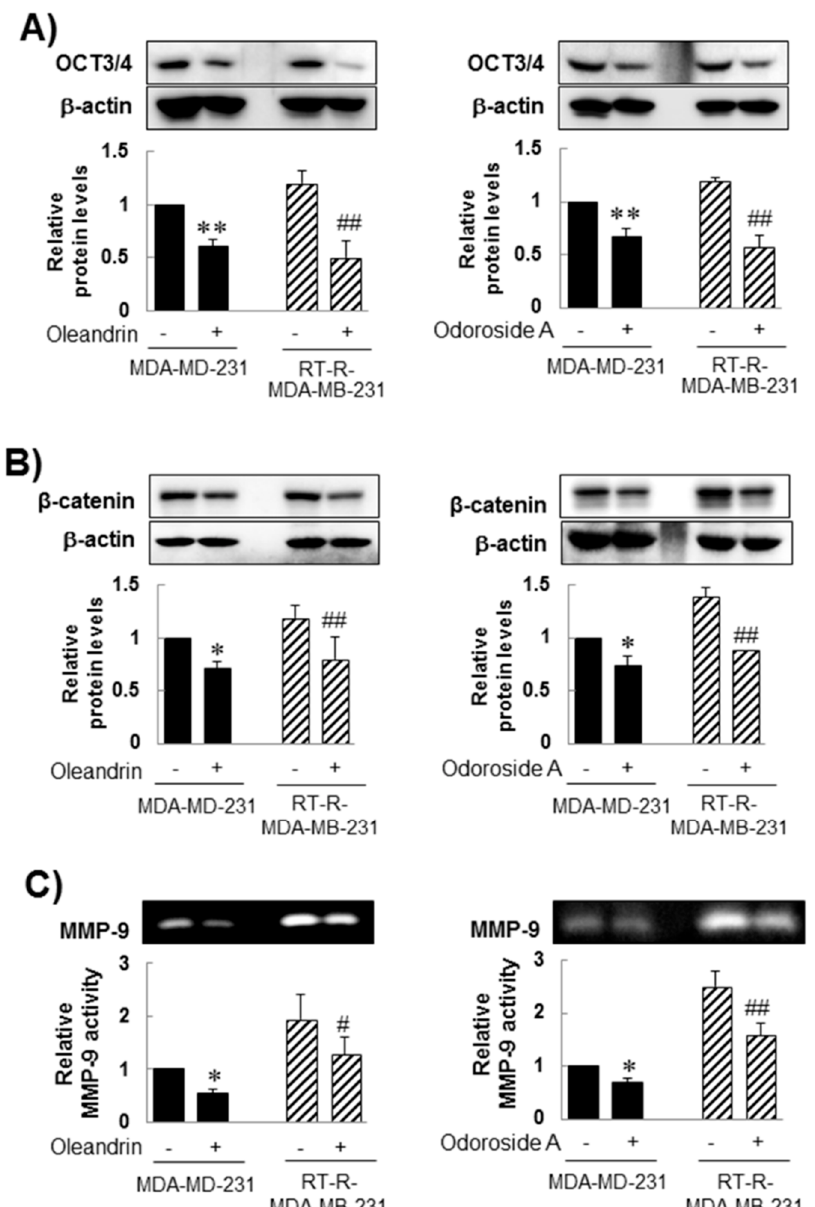
Figure 4. Inhibitory effect of oleandrin and odoroside A on OCT3/4 ( A ) and β -catenin expression ( B ) and MMP-9 secretion ( C ). Cells were treated with oleandrin (50 nM) and odoroside A (100 nM) for 24 h. After treatment, OCT3/4, β -catenin and β -actin protein levels were determined from the cell lysates by western blot analysis ( A , B ), and the gelatinolytic activity of MMP-9 was determined from the media by gelatin zymography as described in the Methods ( C ). The values are expressed as the means ± SEM from three independent determinations. * p < 0.05, ** p < 0.01 compared with the control group of MDA-MB-231 cells; ## p < 0.01 compared with the control group of RT-R-MDA-MB-231 cells.